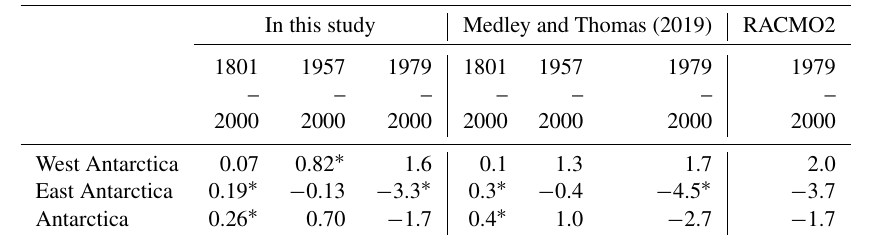
Table 2. SMB trends over grounded (i.e., excluding ice shelves) West Antarctica, East Antarctica, and Antarctica as a whole from (1) our reconstruction based on data assimilation using iHadCM3 outputs and SMB and δ 18 O data in the data assimilation procedure; (2) Medley and Thomas (2019); (3) RACMO2 outputs for various time intervals (Gtyr − 2 ). Asterisks stand for statistically significant trends at the 5% level.